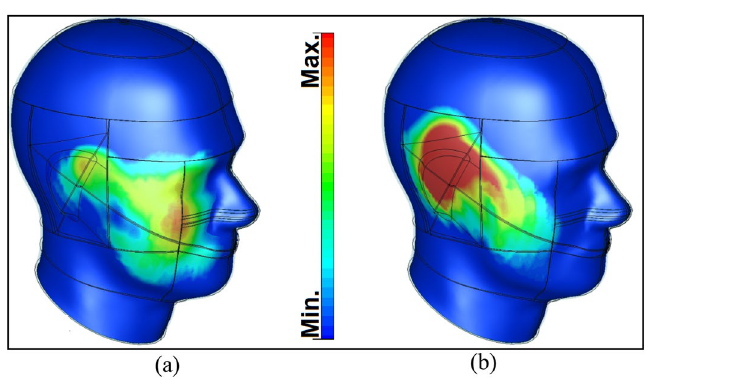
Figure 19. Investigated SAR impacts from ( a ) Antenna 3 and ( b ) Antenna 7.